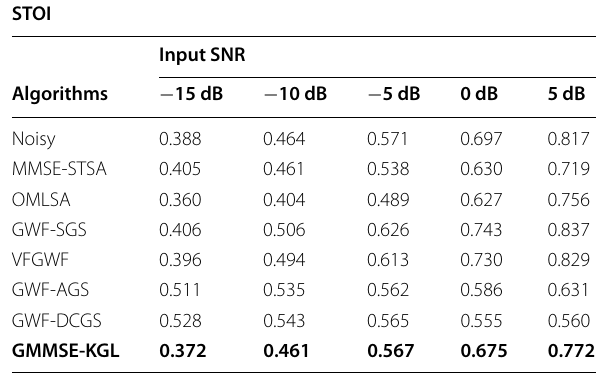
Table 4 The LLR of different methods for white noise